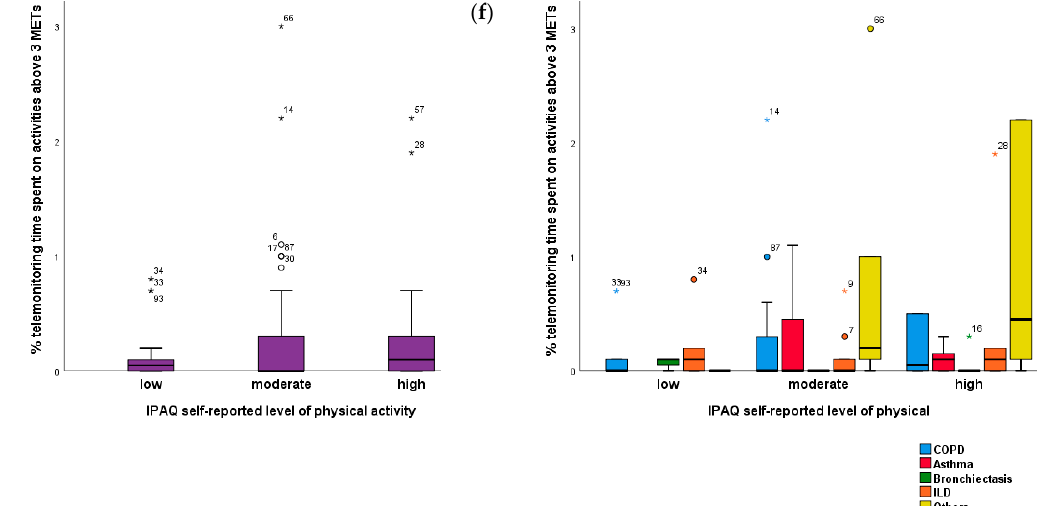
Figure 4. Telemonitoring time: ( a ) spent on activities below 2 METs by self-reported IPAQ level of physical activity; ( b ) spent on activities below 2 METs by self-reported IPAQ level of physical activity per chronic respiratory disease; ( c ) spent on activities between 2 and 3 METs by self-reported IPAQ level of physical activity; ( d ) spent on activities between 2 and 3 METs by self-reported IPAQ level of physical activity per chronic respiratory disease; ( e ) spent on activities above 3 METs by self-reported IPAQ level of physical activity; ( f ) spent on activities above 3 METs by self-reported IPAQ level of physical activity per chronic respiratory disease.